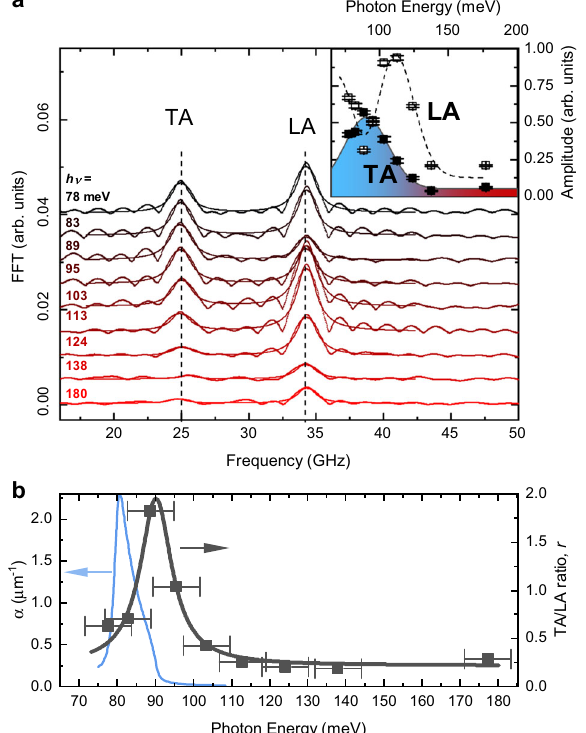
Fig. 4 Tunable shear strain. a Fourier transforms of the measured polarization rotation signals corresponding to strain wave propaga- tion after excitation with different pump energies h ν . Inset: Pump photon energy dependent amplitude of the two oscillations corresponding to LA and TA strain waves for fi xed pump and probe polarizations as obtained from the Fourier transforms shown in panel a . The solid and dashed lines are guides to the eyes. The errorbars account for the uncertainty of the fi t. b Linear absorption due to the infrared-active phonon modes, as taken from ref. 14 (left axis) and ratio r of the TA and LA mode amplitudes (right axis) vs photon energy at constant incident fl uence. The black line serves as a guide to the eye. The spectral full-width at half-maximum of the excitation pulses is indicated by the